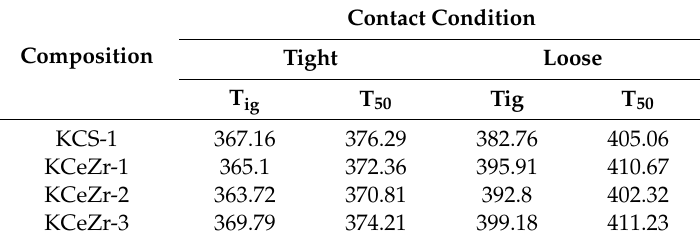
Table 1. T IG and T 50 values of investigated glass compositions.